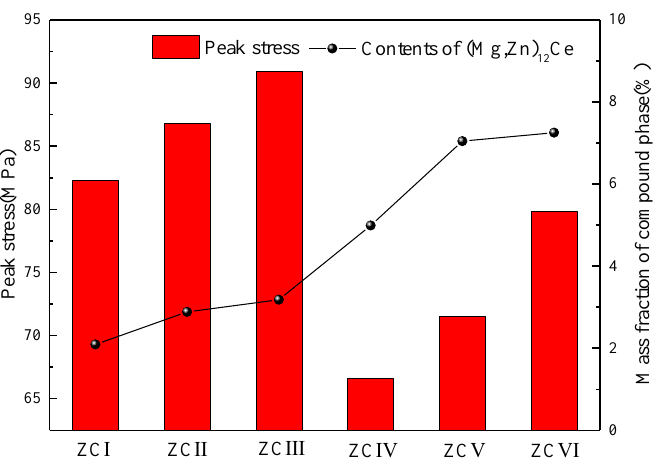
Figure 17. Peak stress of experimental alloys.